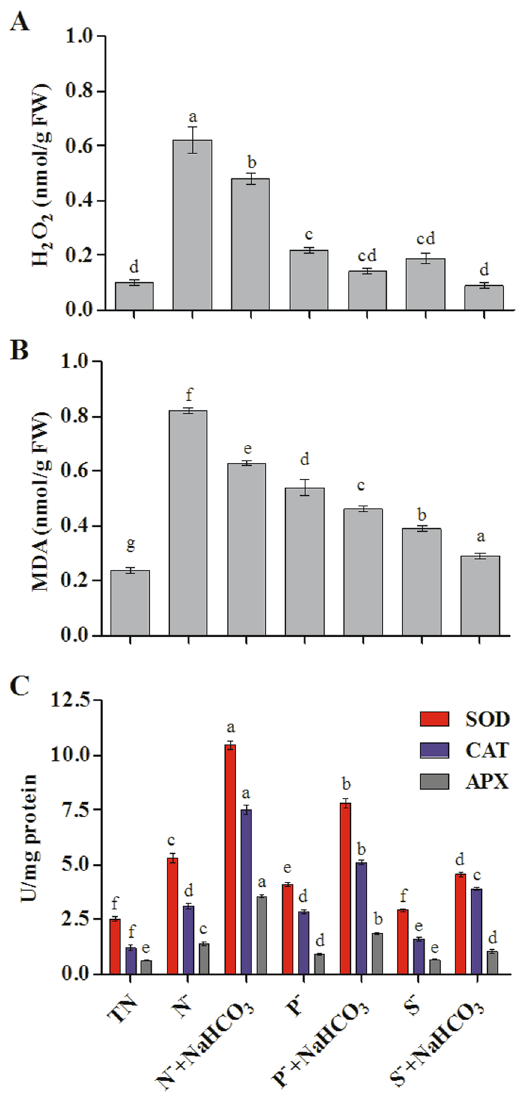
Figure 7. Production of ROS ( A ), lipid peroxidation ( B ) and antioxidant acitivities of SOD, CAT and APX ( C ) of D. salina with bicarbonate under nutrient deficit conditions. All values are expressed as Mean ± SD (n = 3). Values with different letters represent significantly differ at p < 0.05 between the groups. Total Nutrient (TN); Nitrate deficit (N − ); Nitrate deficit with bicarbonate (N − + NaHCO 3 ); Phosphate deficit (P − ); Phosphate deficit with bicarbonate (P − + NaHCO 3 ); Sulphate deficit (S − ); Sulphate deficit with bicarbonate (S − + NaHCO 3